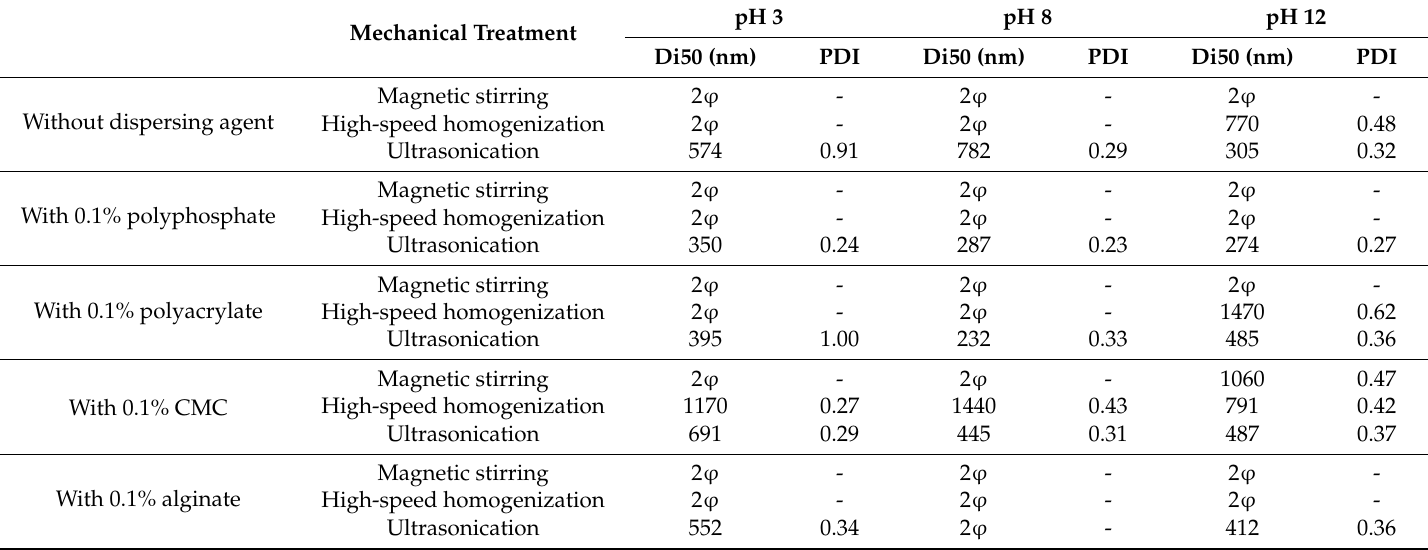
Table 3. Particle sizes of sepiolite 1 as a function of the di ff erent conditions used for preparation of the